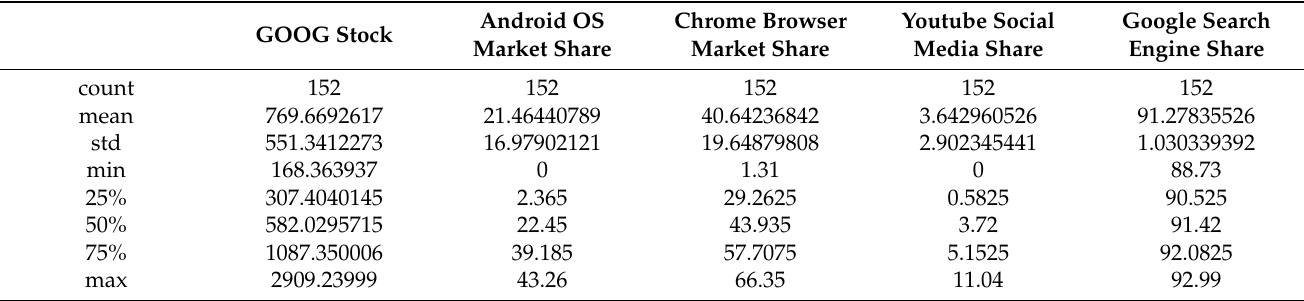
Table 1. Initial data for the following correlation analysis.